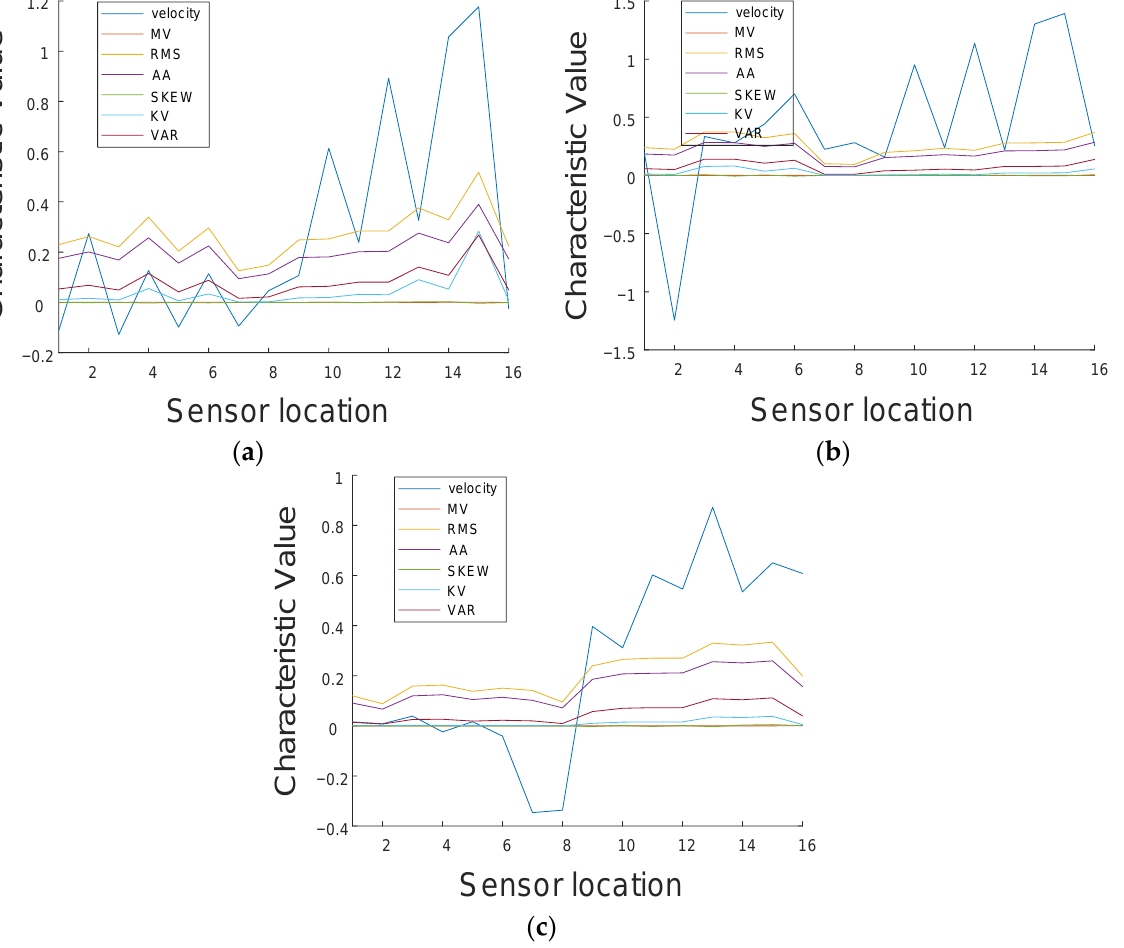
Figure 6. Data characteristics of motion data: ( a ) data characteristics of the first joint, ( b ) data characteristics of the second joint, and ( c ) data characteristics of the third joint.